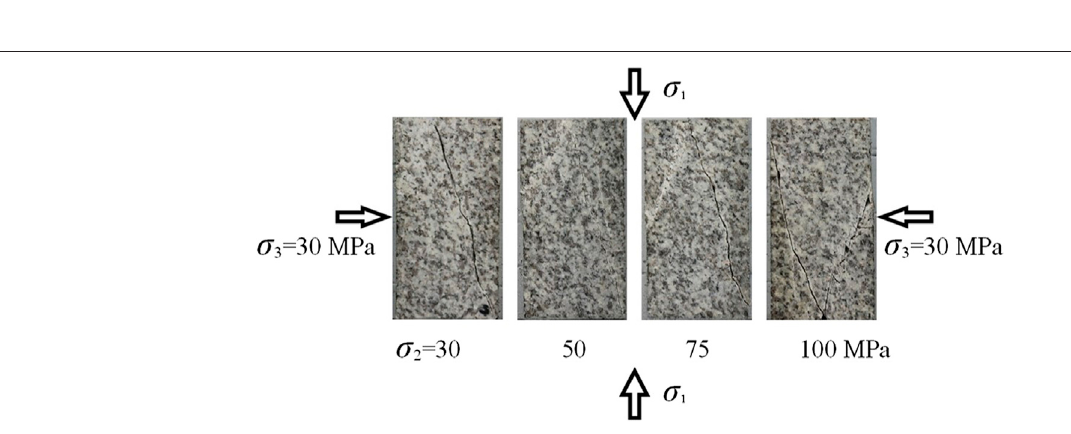
FIGURE 8 | Failure modes of tested granite change with σ 2 when σ 3 is 20 MPa.